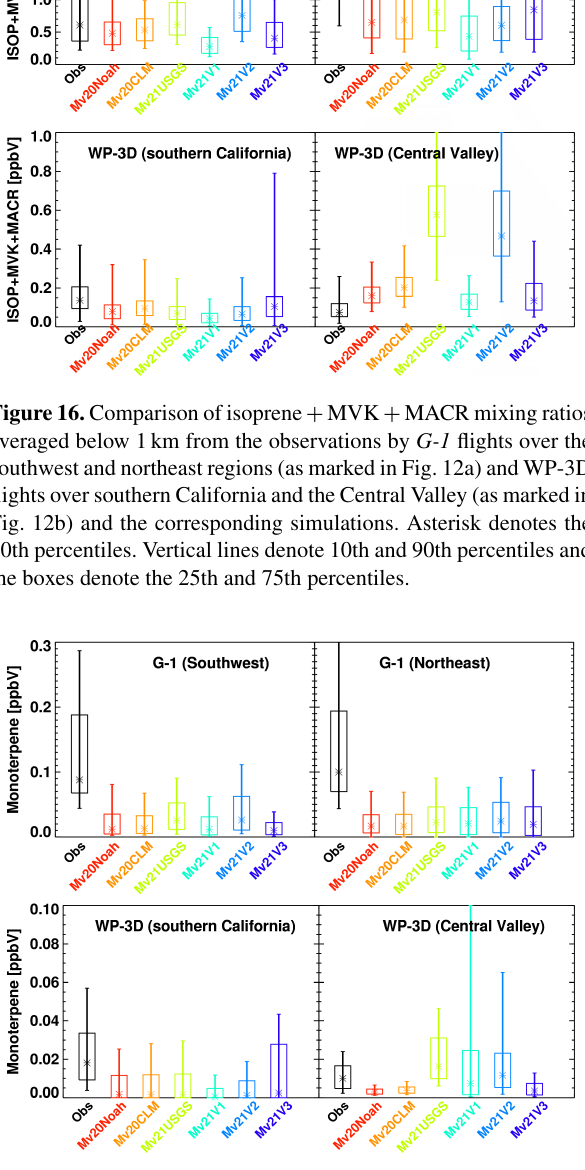
Figure 17. Same as Fig. 16 except for monoterpene mixing